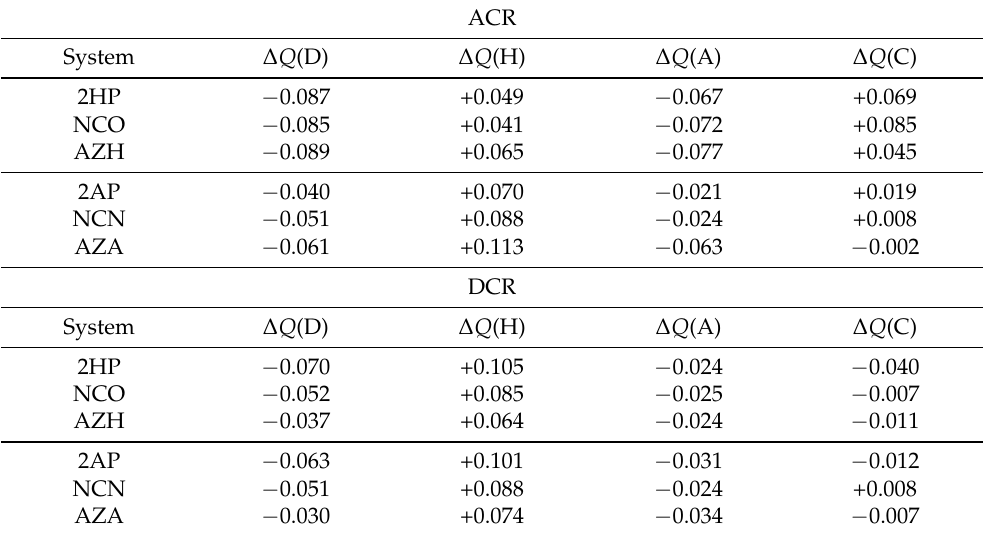
Table 2. Change in the QTAIM electron populations of the atoms involved in the HB contacts upon the formation of the dimers for (i) the hydrogen bond Acceptor Contained within the Ring (ACR) and (ii) the hydrogen bond Donor Contained within the Ring (DCR) cases. The labelling of the atoms is shown in Figure 3. All values are reported relative to the monomers which were used as reference. Atomic units are used